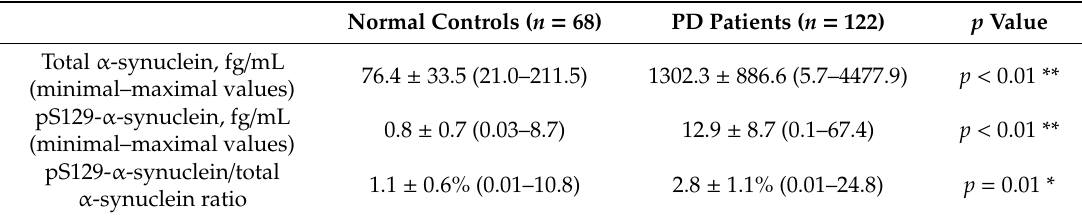
Table 2. Plasma biomarker levels of study